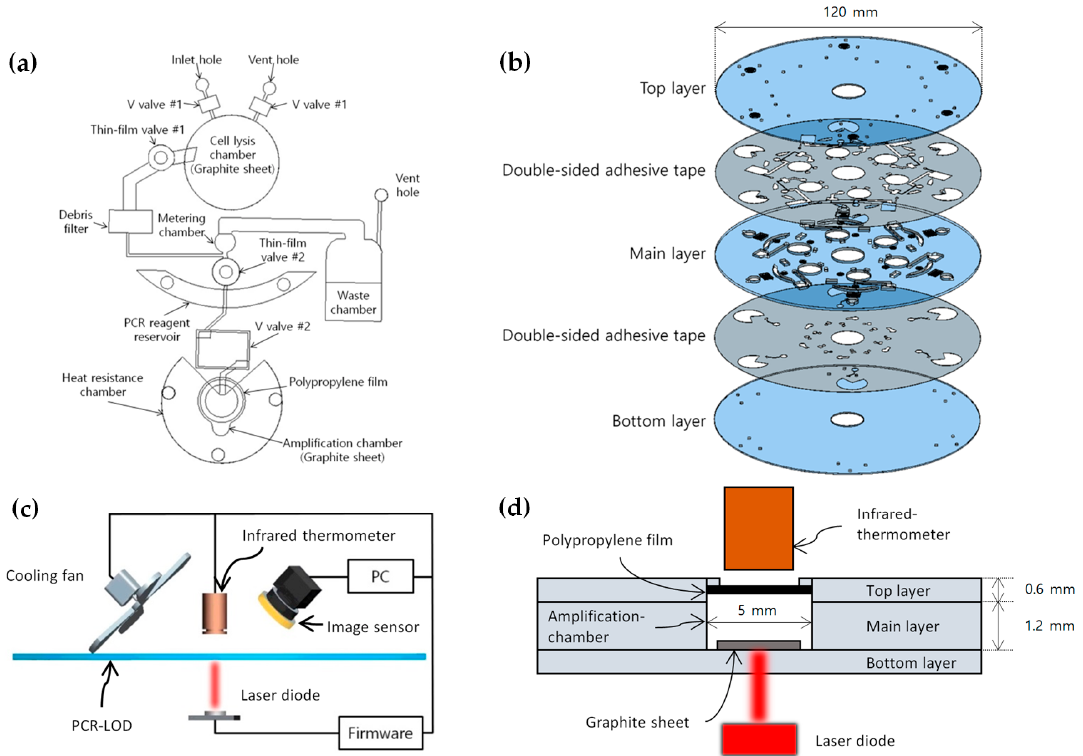
Figure 1. ( a ) The schematic design of a single polymerase chain reaction